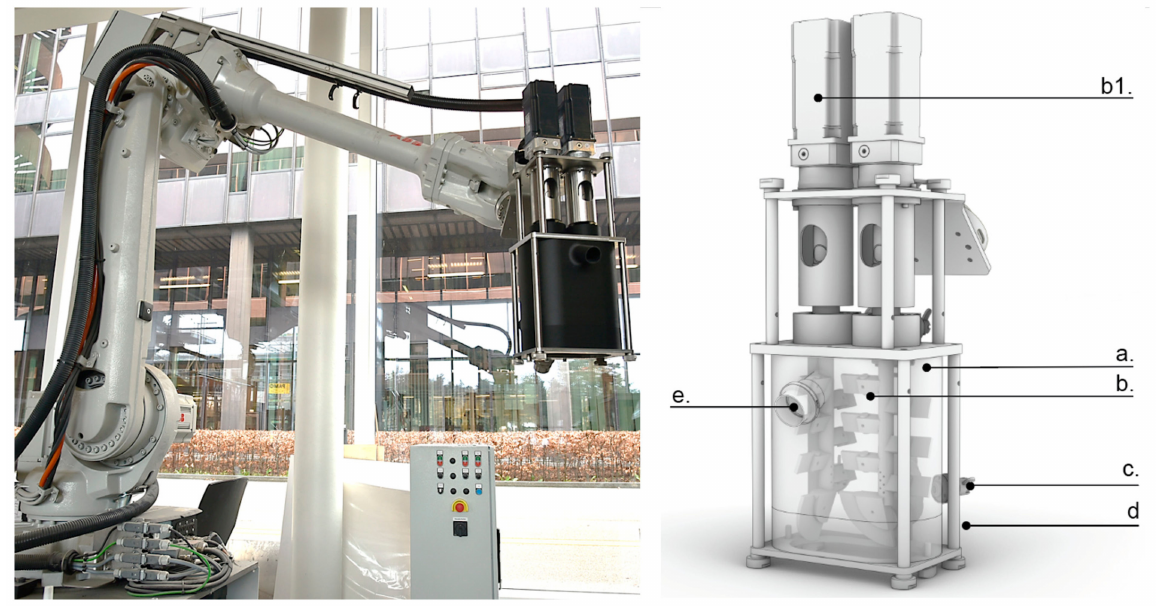
Figure 4. ( left ): Inline mixer mounted on a 6-axis robotic arm; ( right ): schematic overview of components in the inline